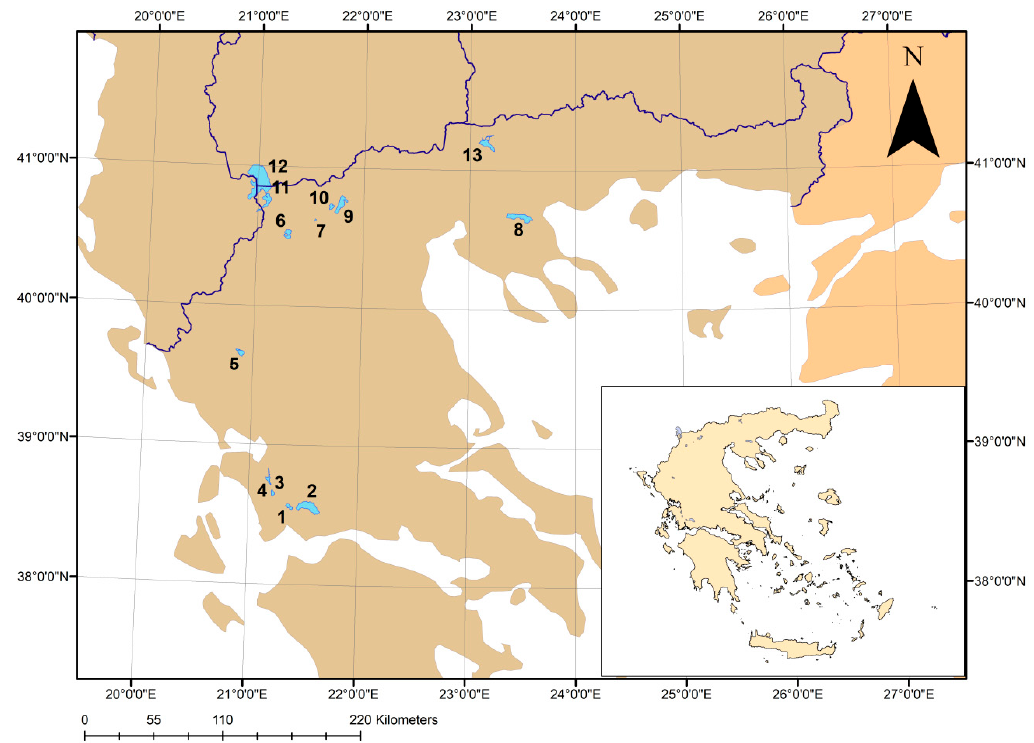
Figure 1. Map showing the location of the studied lakes in Greece. 1: Lysimachia, 2: Trichonida, 3: Ozeros, 4: Amvrakia, 5: Pamvotida, 6: Kastoria, 7: Zazari, 8: Volvi, 9: Vegoritida, 10: Petron, 11: Mikri Prespa, 12: Megali Prespa, 13: Kerkini. Table 1. Geographic location, altitude, and morphological descriptors of the studied lakes (Source [29]).